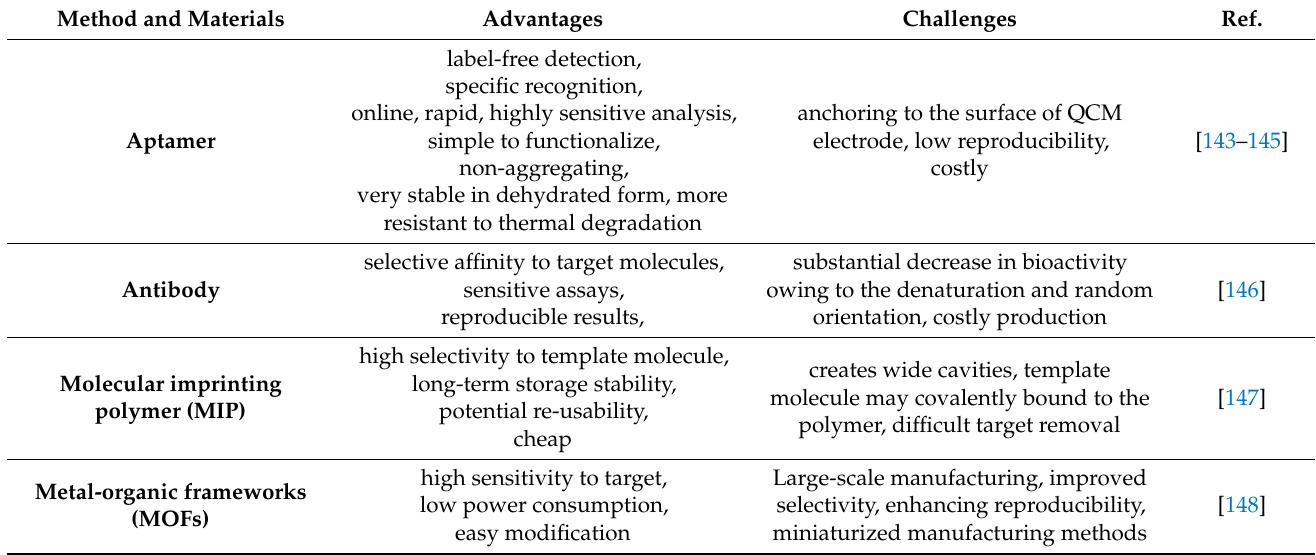
Table 1. The advantages and major challenges of QCM biosensors prepared by various techniques. Method and